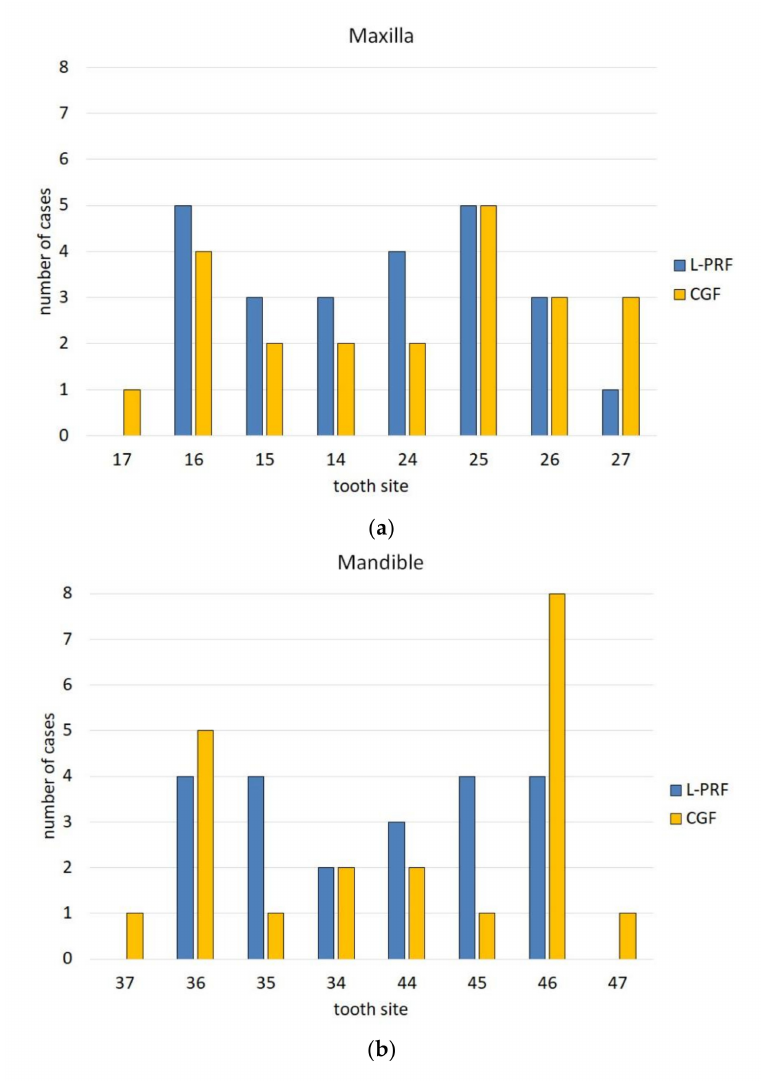
Figure 1. Tooth distribution in the two groups ( a ) maxilla; ( b )